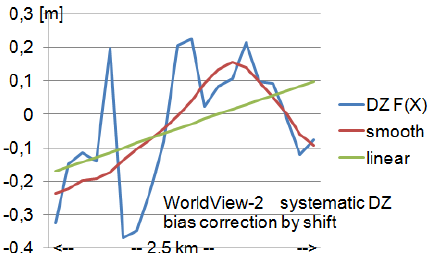
Figure 17. Systematic discrepancies of WorldView-2 DSM model 2 based on bias correction by shift against LiDAR DSM; only for non-forest area without quarries, as function of X